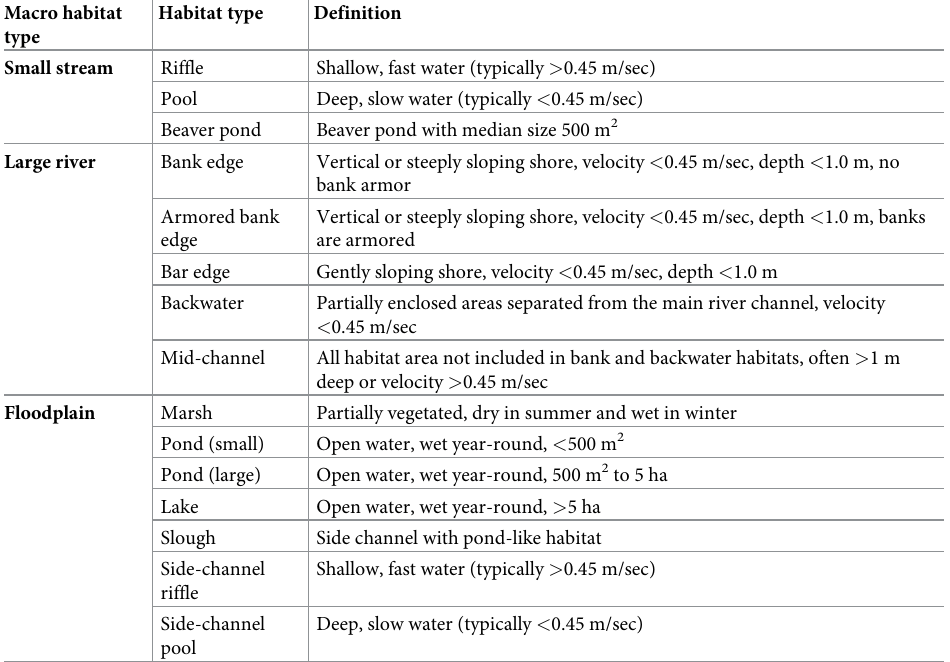
Table 2. Habitat typing